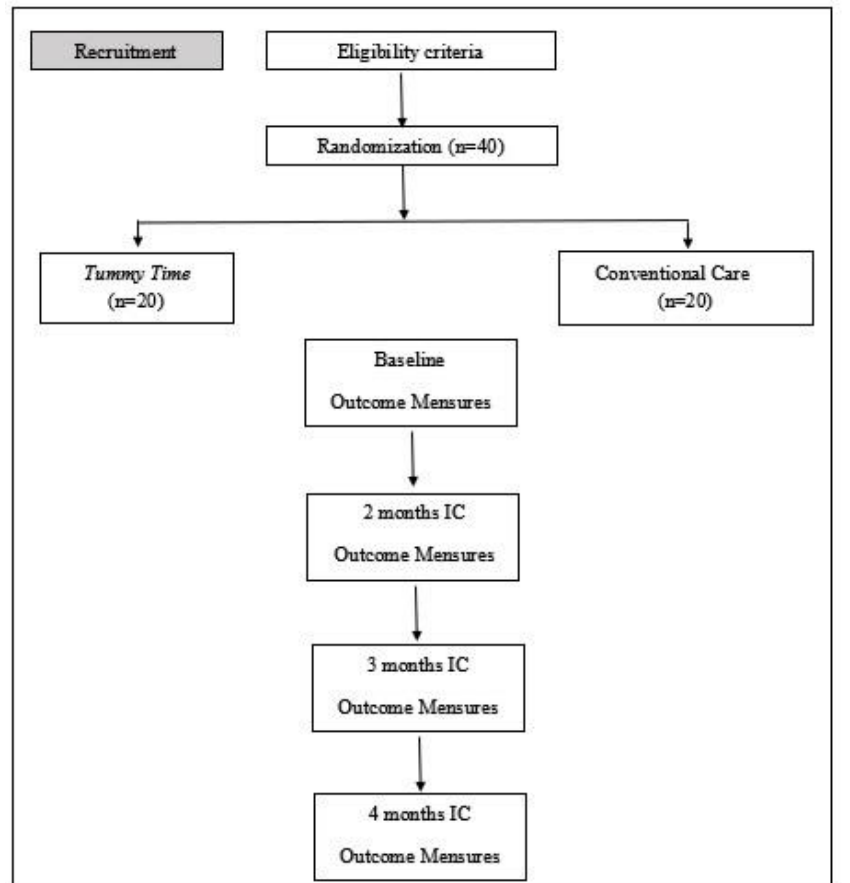
Figure 2. Study schema.